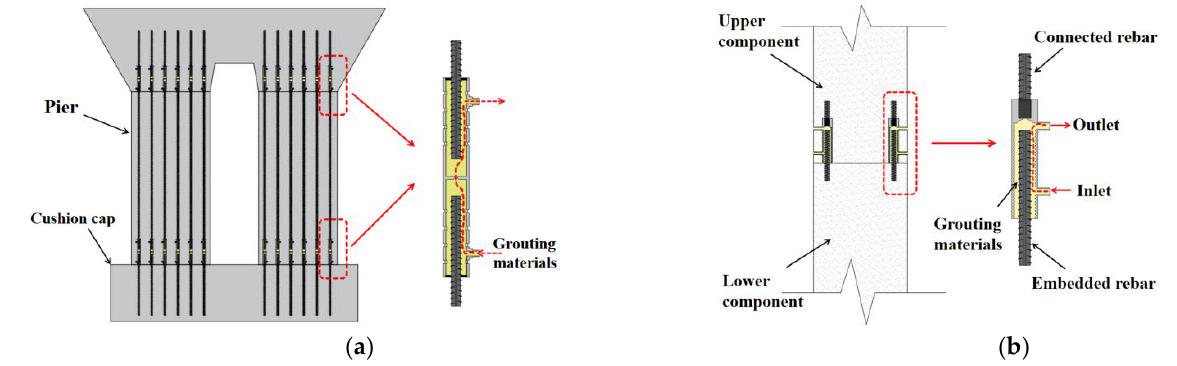
Figure 1. Grouted sleeves. ( a ) Full-grouted sleeve. ( b ) Half-grouted sleeve.